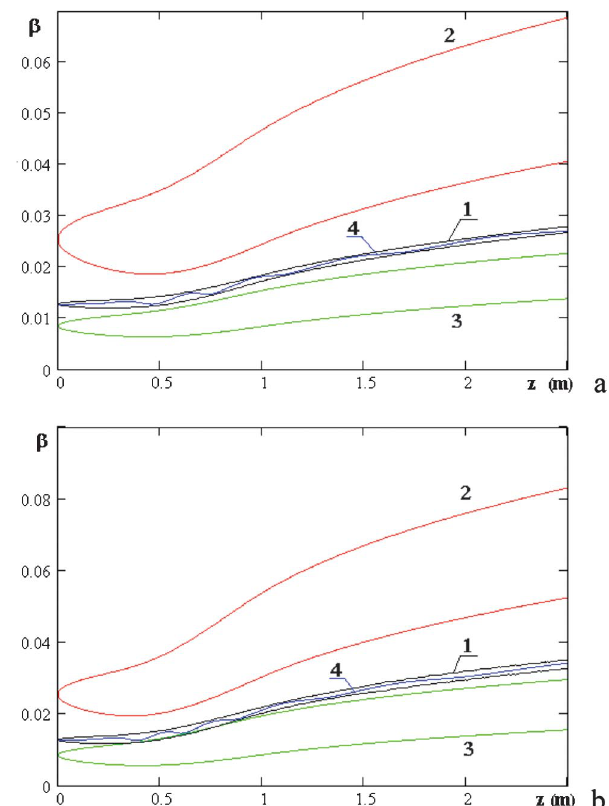
FIG. 2. (Color) The variation of the vertical size of the separatrix of the combined wave as a function of the longitudinal coor- dinate z (curve 1), zero (curve 2), and first (curve 3) rf field harmonics and of the longitudinal particle velocity in the smooth approximation (curve 4) for (cid:10) (cid:1) 0 : 3 (a) and 0.6